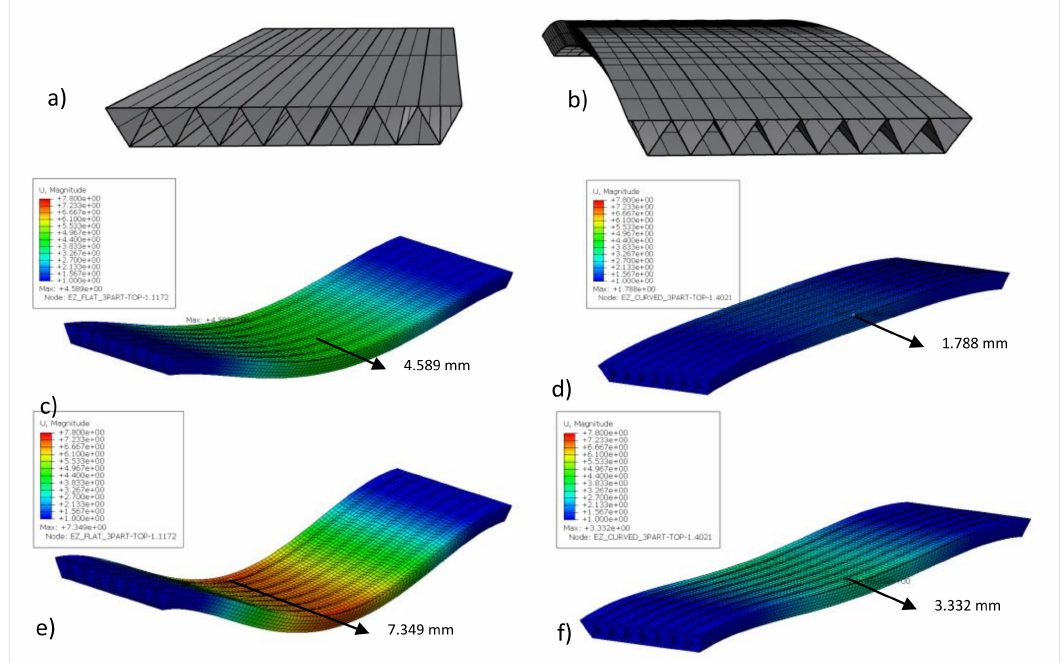
Figure 6. Geometry of: ( a ) EZSpan and ( b ) EZSpan in an arch. Deformation for: ( c ) EZSpan (laminate); ( d ) EZspan (laminate) in an arch; ( e ) EZspan (quasi-isotropic); ( f ) EZspan (quasi-isotropic) in an